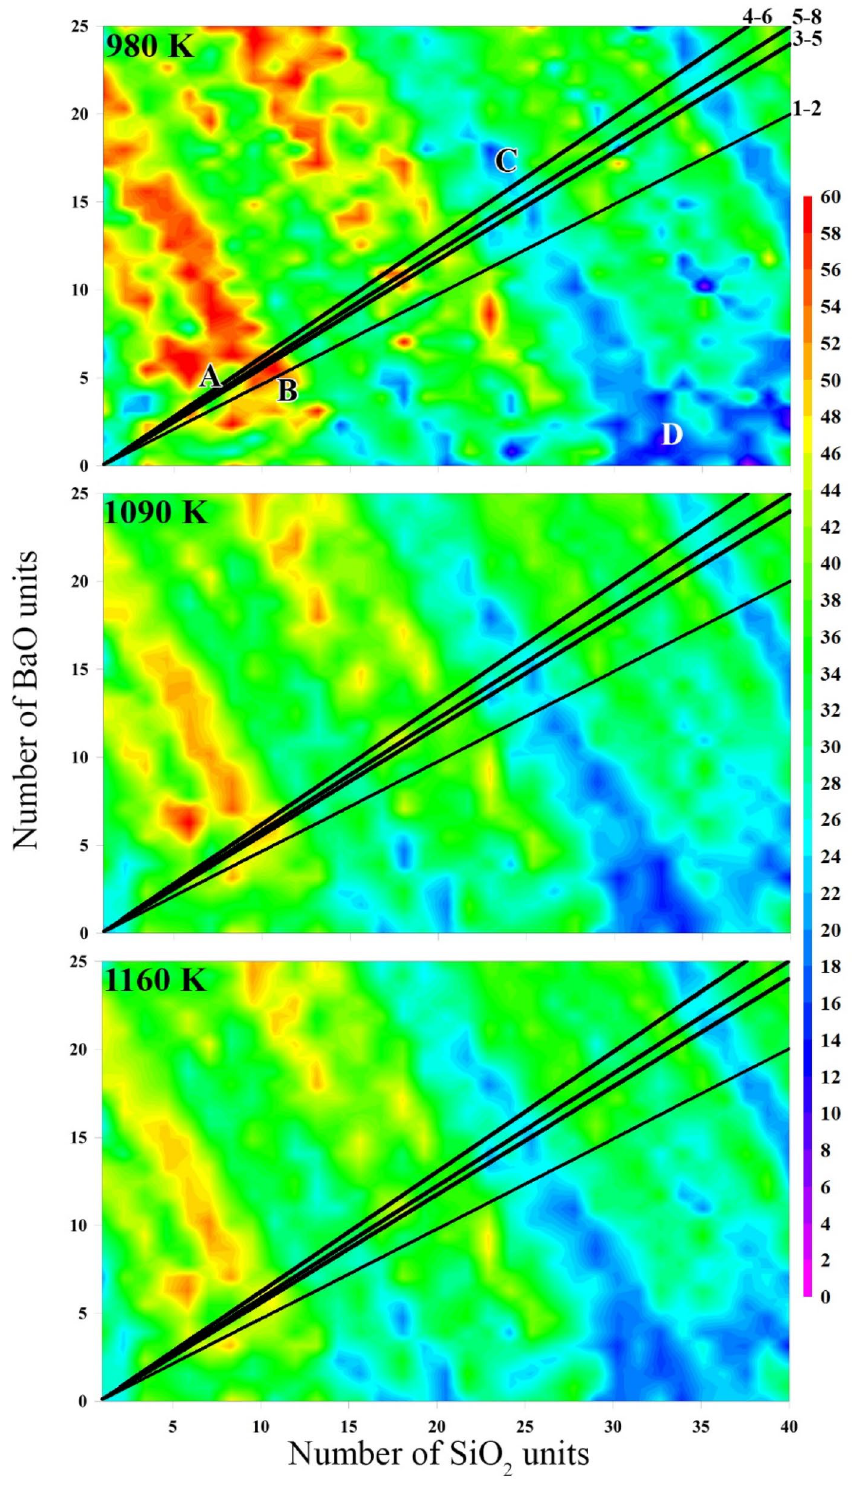
Figure 2. NFE contour maps of the sampled barium silicate clusters. The number of BaO and SiO 2 units are on the y and x axis, respectively. The temperature is in the upper left of each contour plot. The NFE contour coloring scheme is located on the right, in units of k B T. Different barium silicate polymorphs correspond to the different diagonal lines in each of these three maps and their designation is labelled in the upper left side of the 980 K map. The labels are explained in the text and appear in the 980 K plot. The error for all contour plots’ points is between 1–1.3 kT, like Fig.